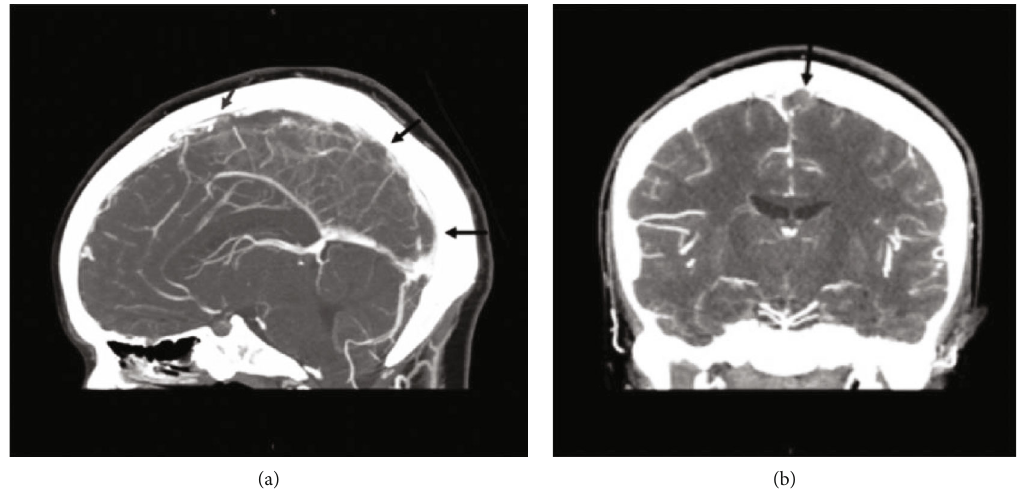
Figure 1: (a) CT venogram with sagittal images with fi lling defects of the superior sagittal sinus (arrows). (b) Coronal images with fi lling defects of the superior sagittal sinus (arrow).